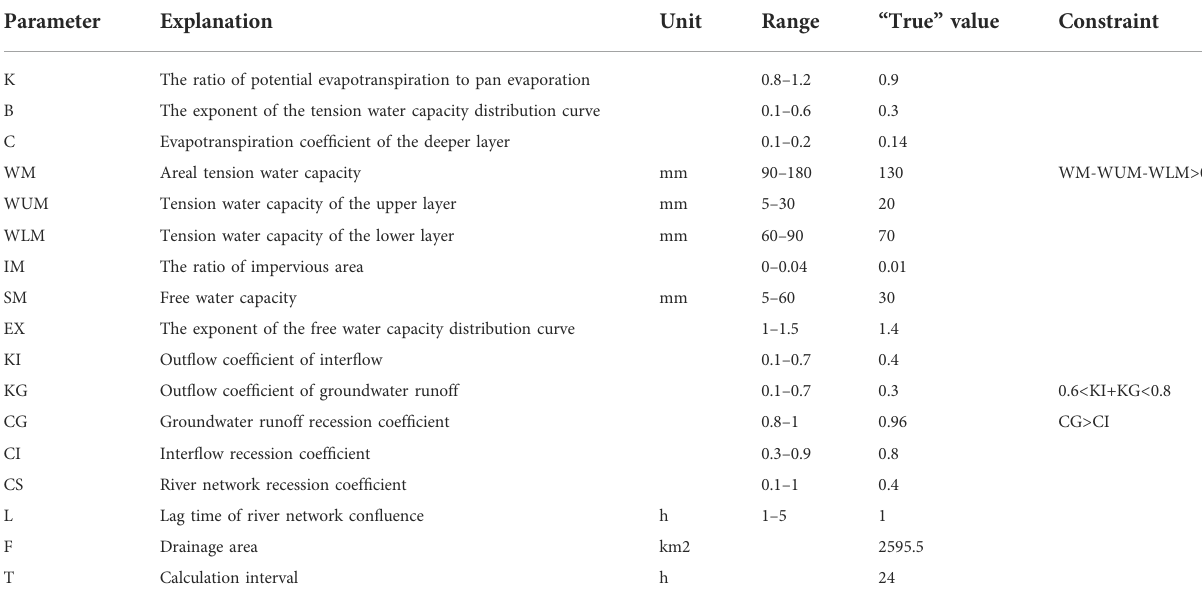
TABLE 4 Parameters of the XAJ model using synthetic